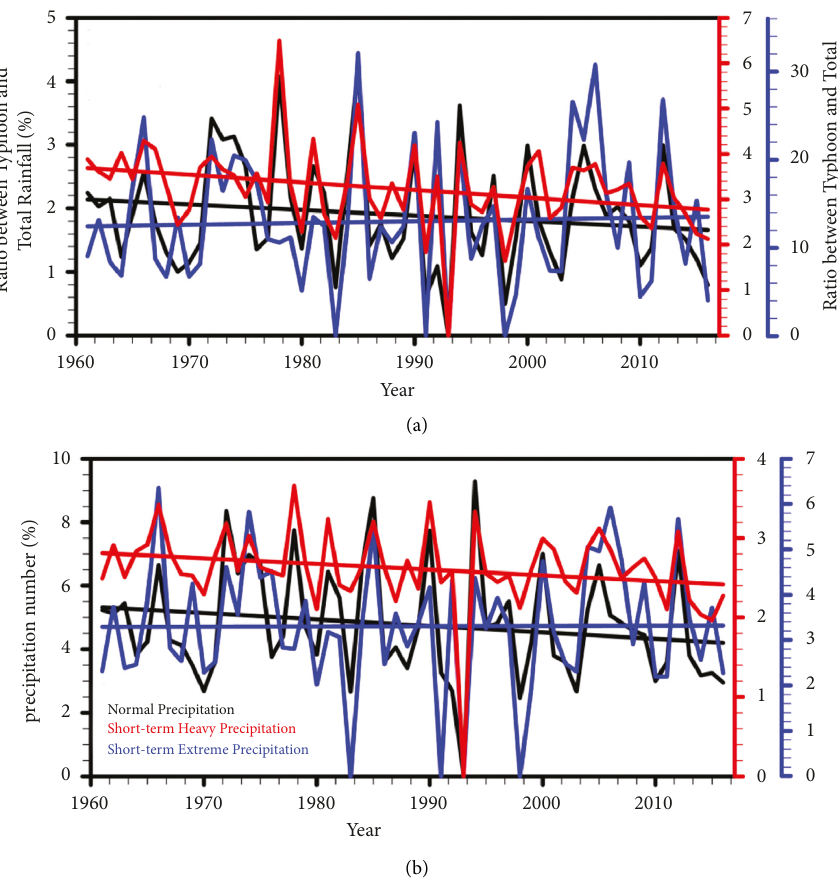
Figure 4: Time series of the (a) amount of precipitation and (b) the number of precipitation events induced by typhoons during the summers of